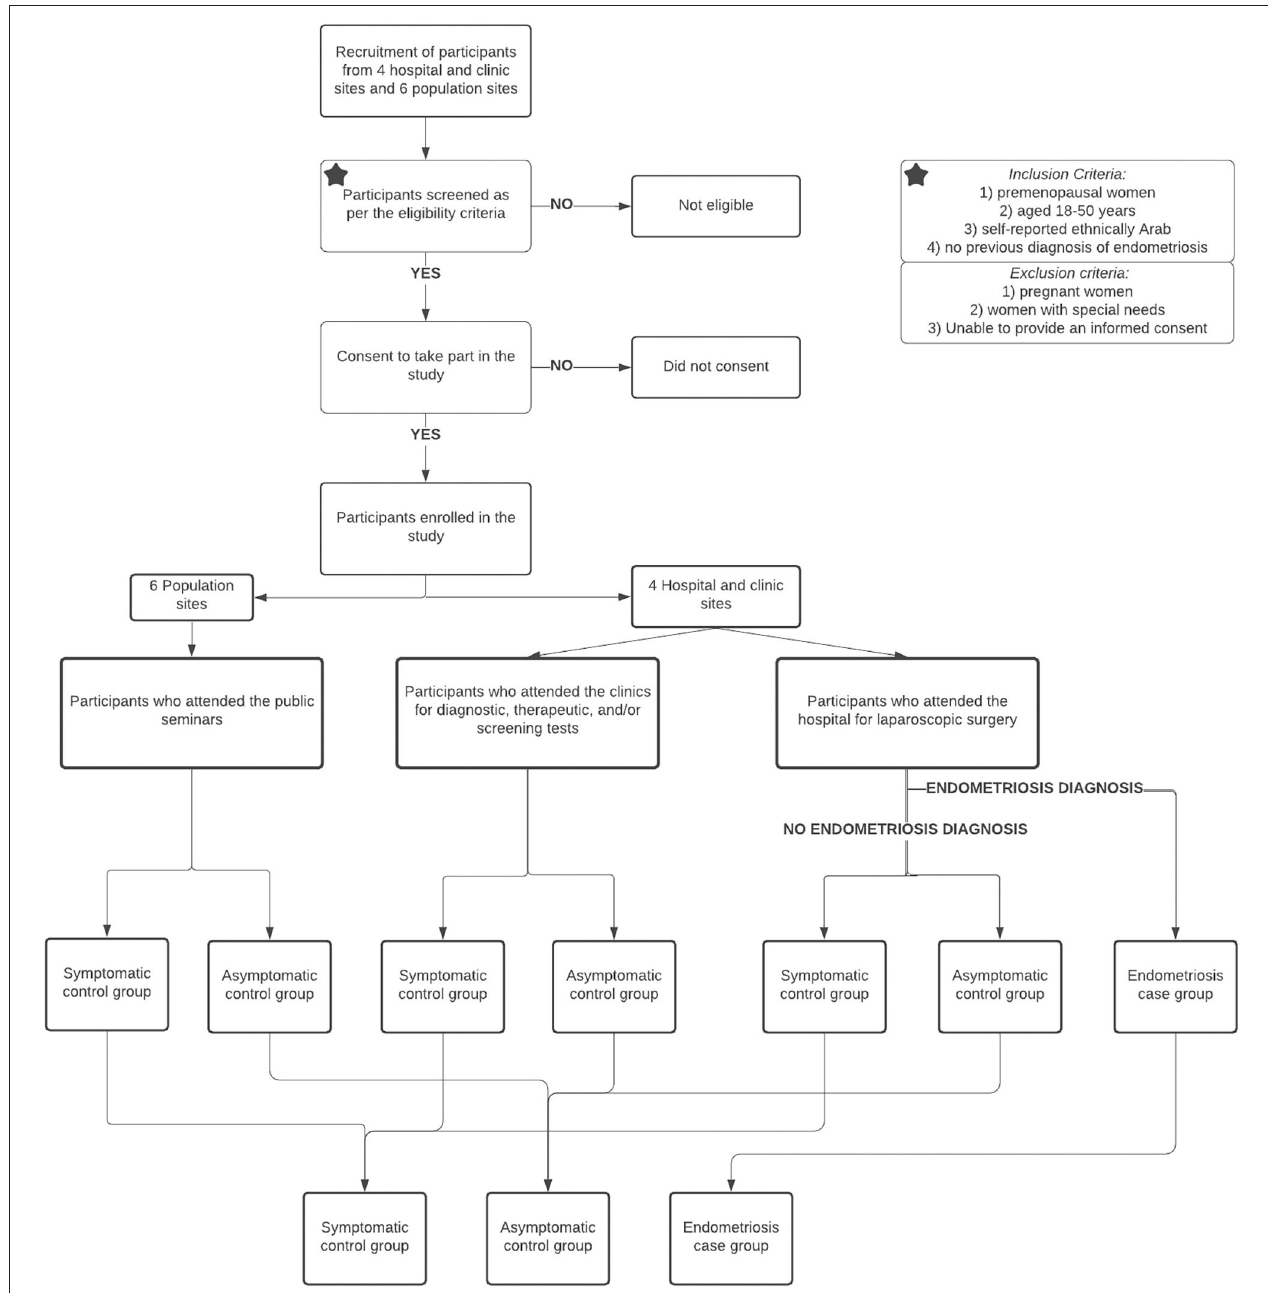
FIGURE 1 | Recruitment flow chart of the study.